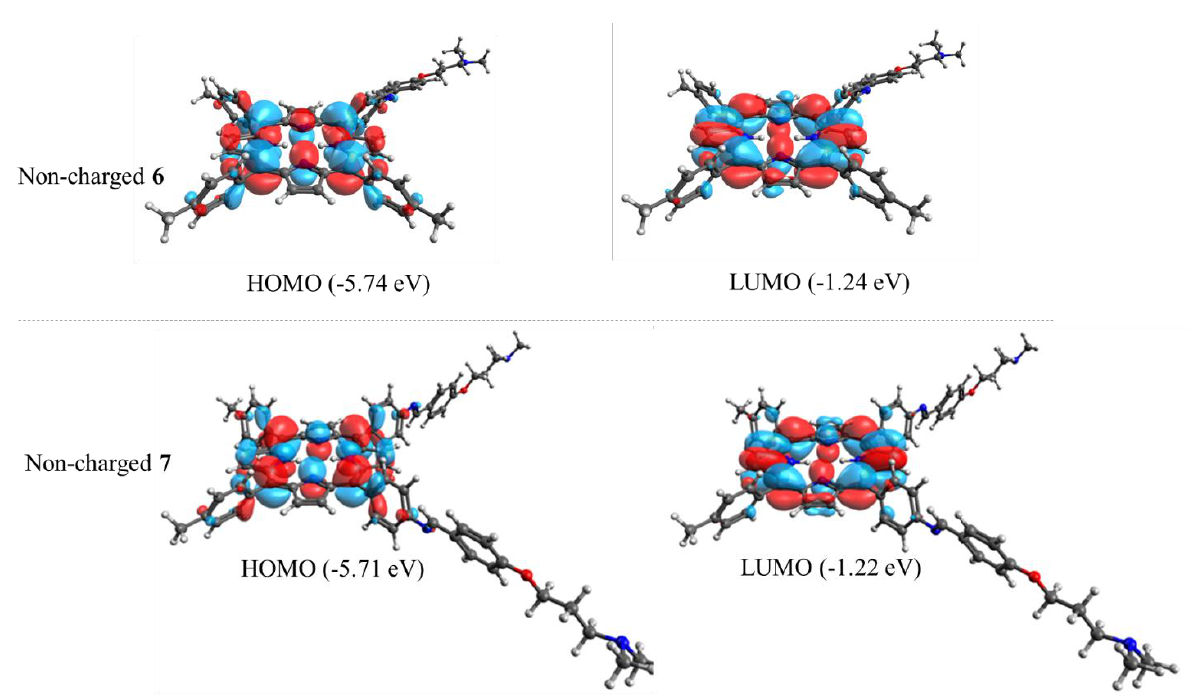
Figure 3. Highest occupied molecular orbital (HOMO) and lowest unoccupied molecular orbital (LUMO) of non-charged porphyrins 6 (up) and 7 (down). All calculations were performed by DFT at the CAM-B3LYP/6 – 31 + G(d) level using Gaussian 09.